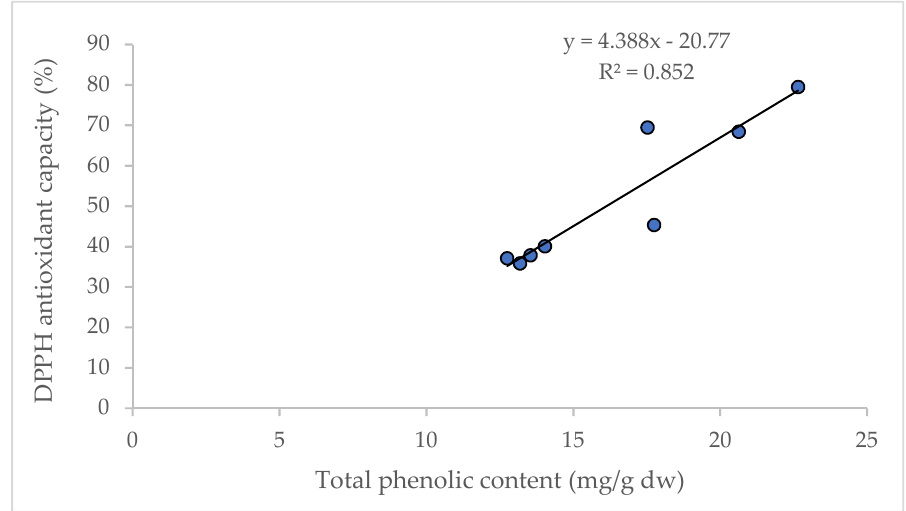
Figure 5. Linear regression between total phenolic content and antioxidant capacity (DPPH assay).